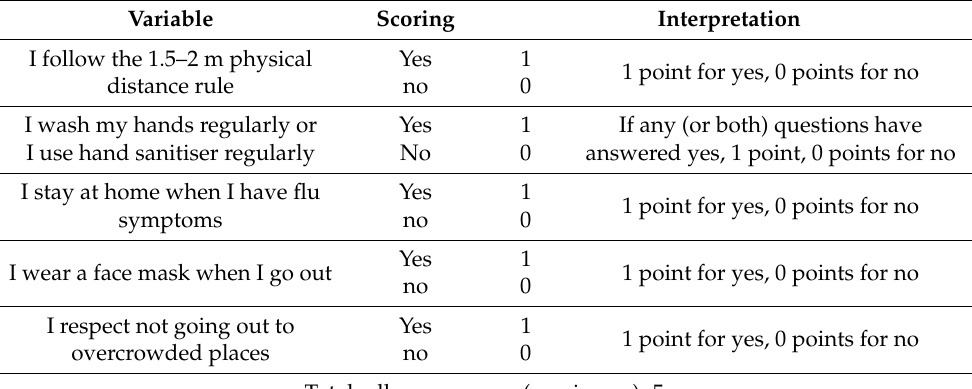
Table 1. Composition of the adherence score to COVID-19 preventive